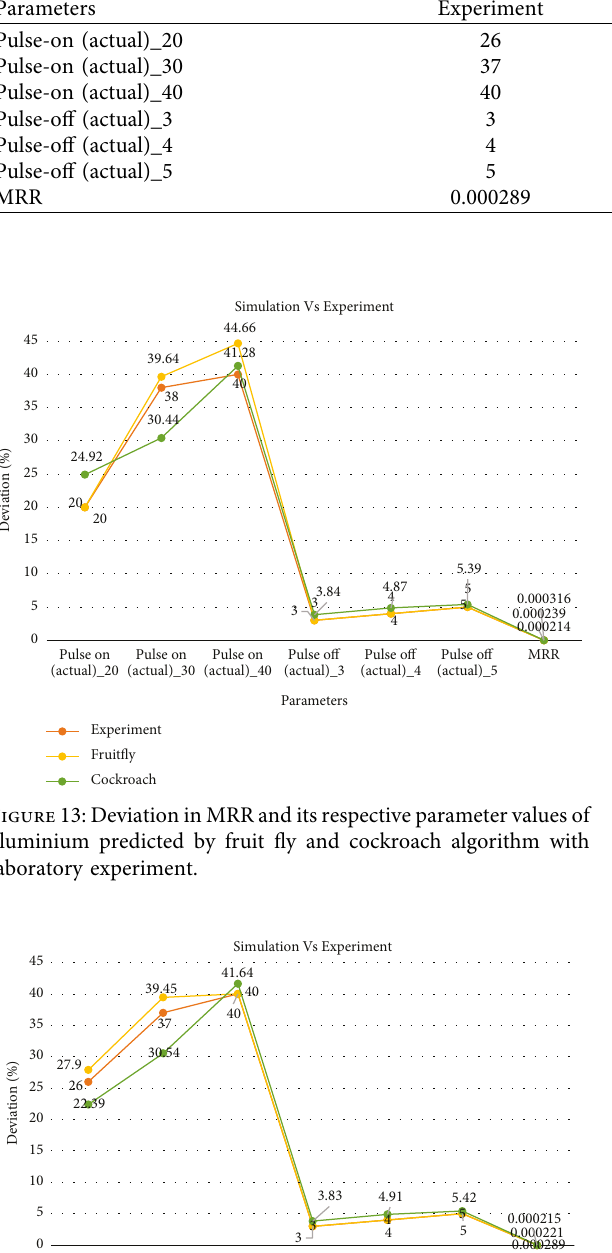
Table 26: Comparison between the values predicted using fruit fly and cockroach algorithms with the experimental values for mild steel.